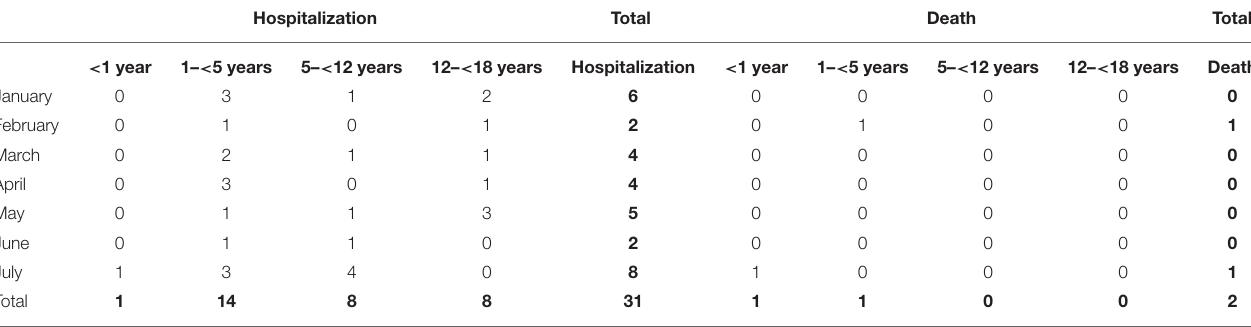
TABLE 3 | Hospitalization and death by age group of children infected with SARS-CoV-2 between January and July 2021 at Murni Teguh Memorial Hospital.